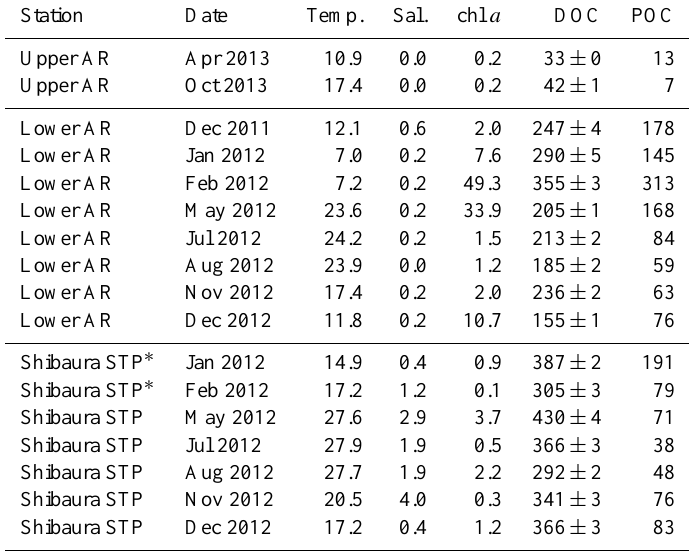
Table 1. Temperature ( ◦ C), salinity, chl a concentrations (µgL − 1 ), DOC concentrations (µmolL − 1 ) ± standard deviation, and POC concen- trations (µmolL − 1 ) at the upper Arakawa River (upper AR), the lower Arakawa River (lower AR), and Shibaura STP stations.